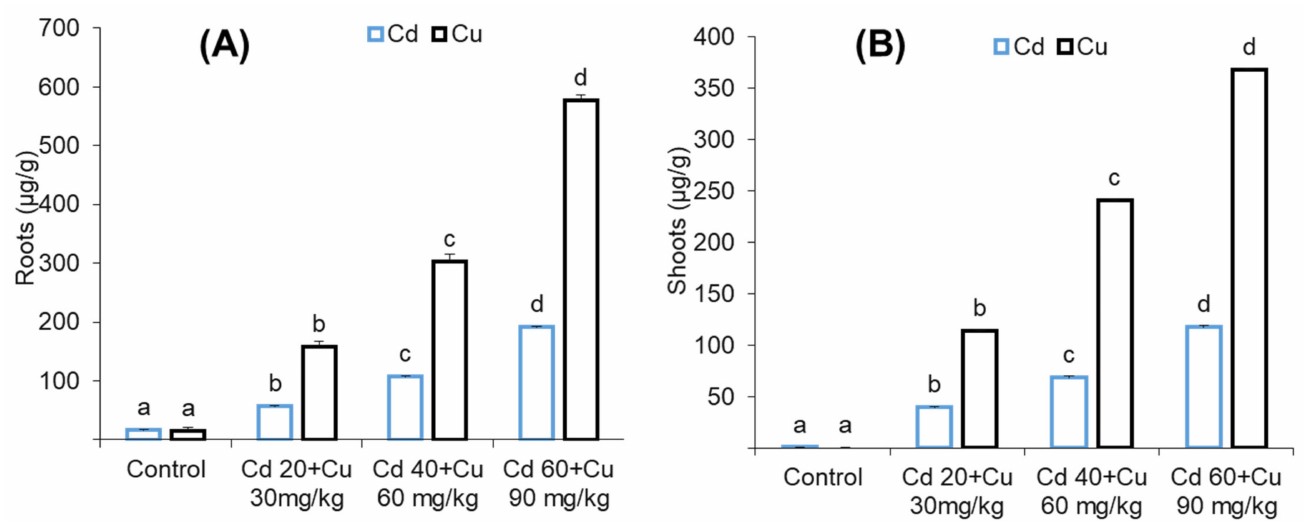
Figure 5. The effect of different cadmium and copper concentrations (0, Cd 20 + Cu 30 mg/kg, Cd 40 + Cu 60 mg/kg, and Cd 60 + Cu 90 mg/kg) on shoot ( A ) and root ( B ) metal accumulation of cadmium and copper in pigeon pea plant. Bars represent means from the three independent replicates ( ± , n = 3); different letters indicate significant differences between the treatments at p <